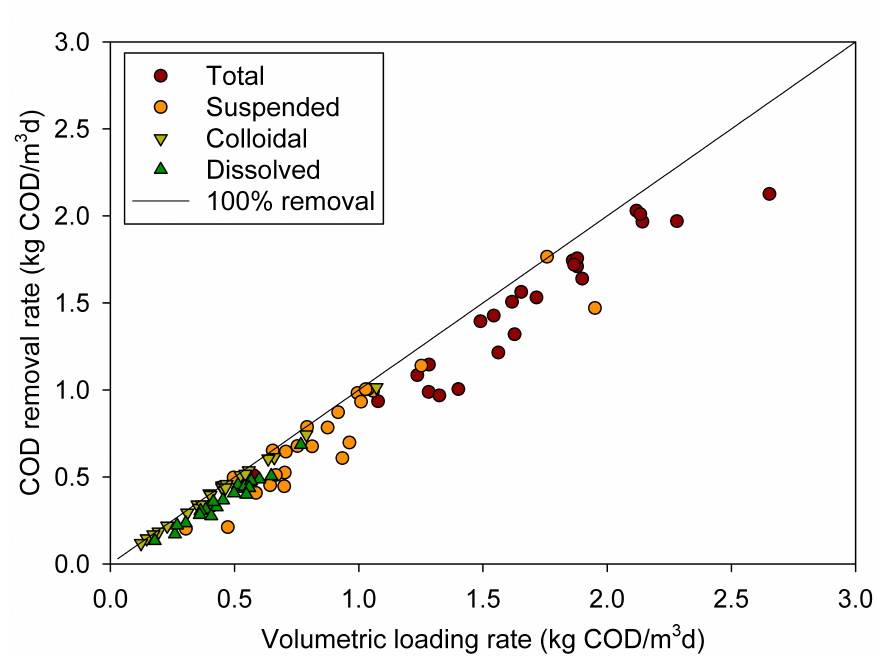
Figure 2. COD removal rate vs. volumetric loading rate in SBR12.